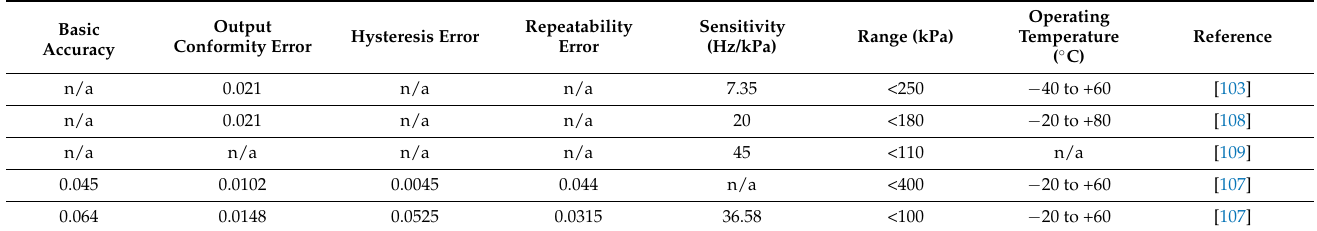
Table 6. Efficient resonant action pressure sensors performance comparison.